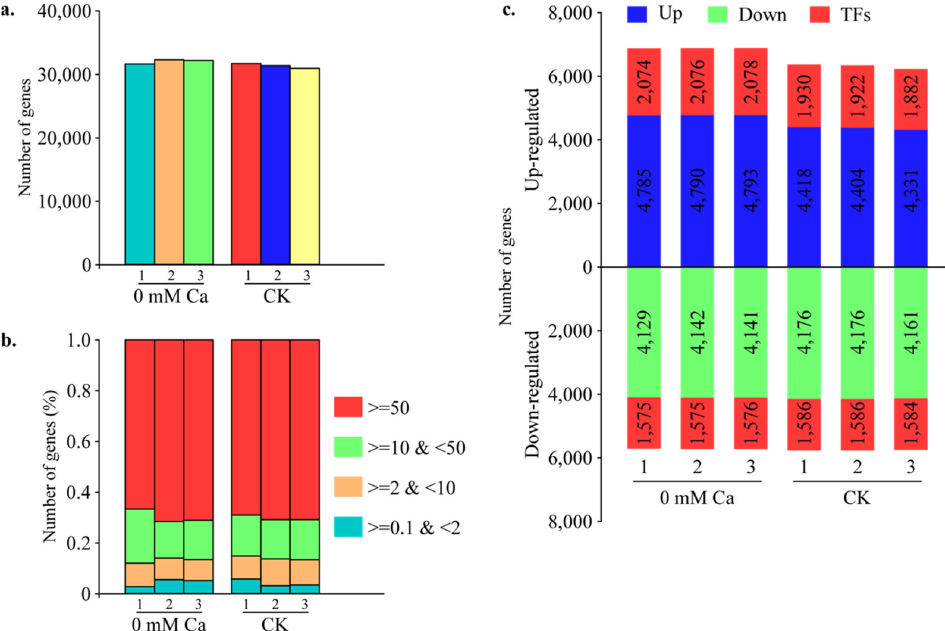
Figure 3. Gene expression in CK and 0 mM Ca treatment Chinese cabbage seedlings. ( a ) A total number of genes expressed in CK and 0 mM Ca treatment. ( b ) Fraction of genes expressed at different samples (based on FPKM). ( c ) Comparison of genes in up and downregulation in CK and 0 mM Ca treatment.